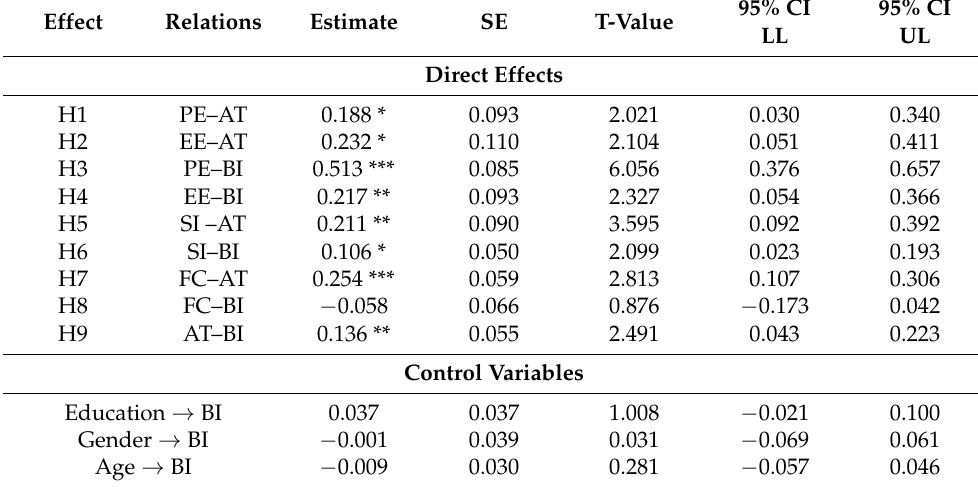
Table 3. Effects on endogenous